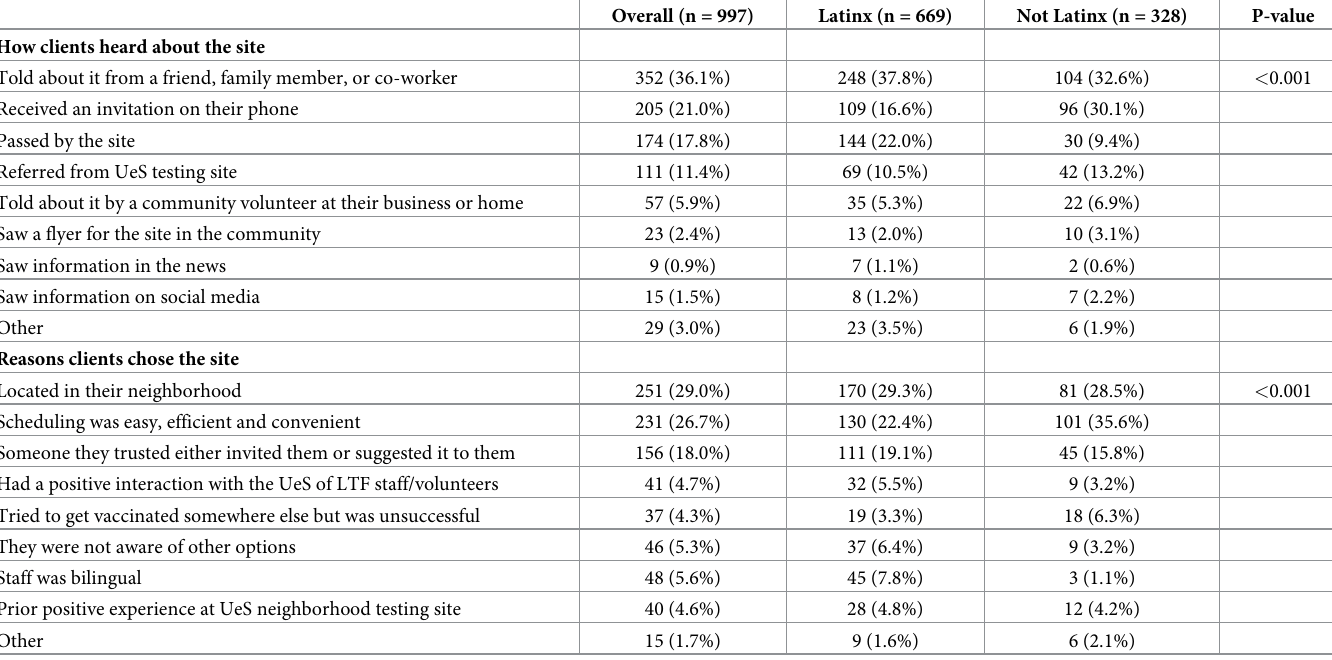
Table 3. Factors influencing and motivating clients to get vaccinated at the at the Unidos en Salud neighborhood